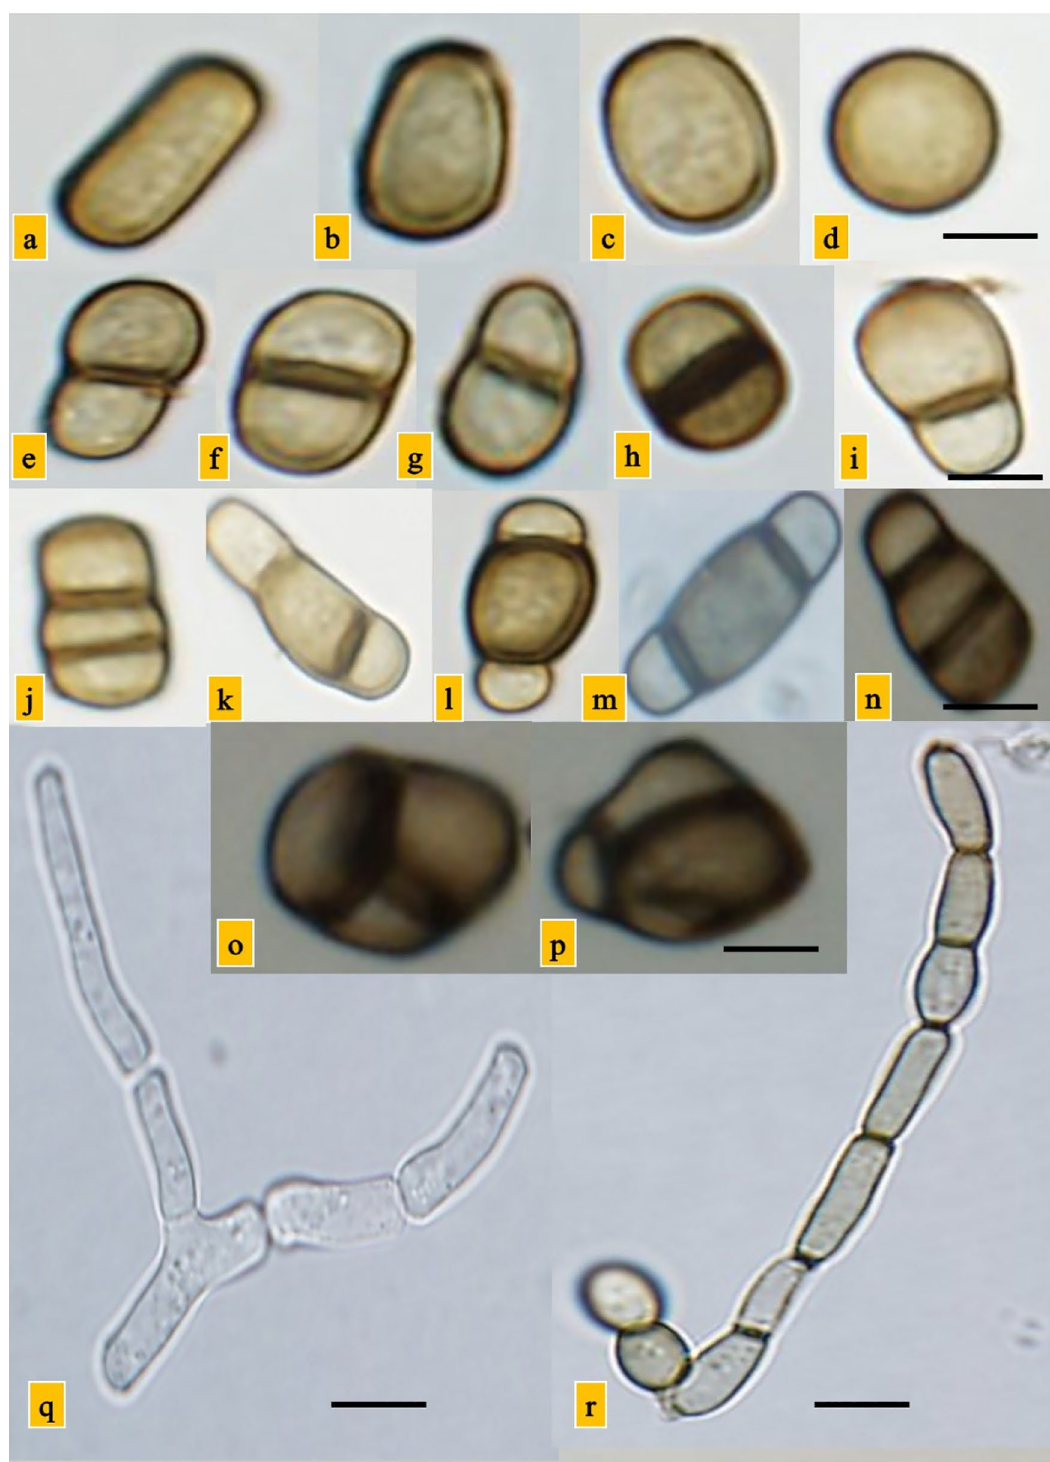
Figure 2. Spores of Neoscytalidium novaehollandiae ; light brown aseptate conidia ( a , b , c and d ); light brown 1-septate conidia ( e , f , g , h and i ) light brown two-septate conidia ( j , k , l , m , and n ); muriform conidia ( o and p ); Chains of arthroconidia ( q and r ; q: premature of arthroconidia and r: mature of arthroconidia). Scale bars: a, b, c and d = 3 μm; e, f, g, h, i, j, k, l, m, and n = 4 μm; o and p = 2.5 μm; q and p = 5